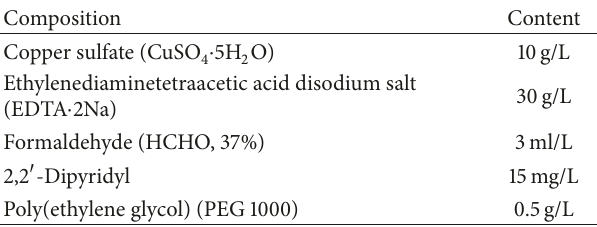
Table 1: The compositions of the electroless copper plating bath.